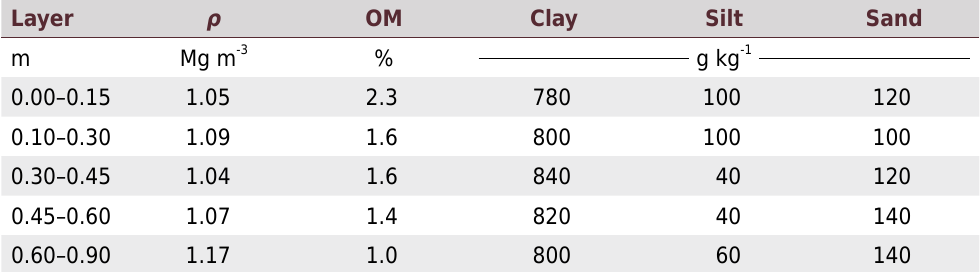
Table 1. Soil physical properties, soil organic matter content (OM) and texture determinations performed on a composite soil sample Layer ρ OM Clay